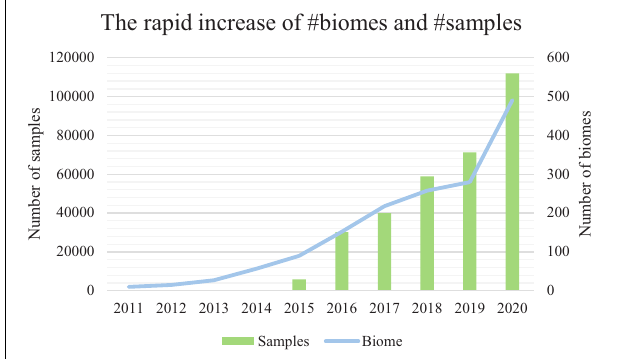
FIGURE 1 | The accelerating number of microbiome samples, and the rapidly diversified biomes from where they are collected. Results are based on the assessment of the EBI MGnify database (publically available samples) from the year 2011 to the year 2020. The primary (left) vertical axis is the number of samples. The secondary (right) vertical axis is the number of biomes. EBI MGnify database is pubilc and